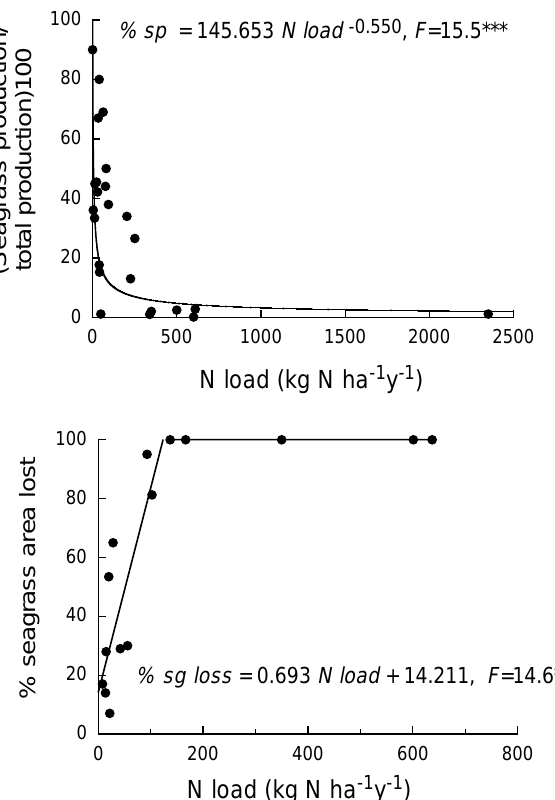
F IG . 6. – Top: Seagrass production as % of total production versus land-derived nitrogen load to the estuary. Bottom: Percentage of area of seagrass habitat lost (over last 10 to 30 years) in several estuaries, plotted versus the corresponding land-derived nitrogen load. From Valiela and Cole (in